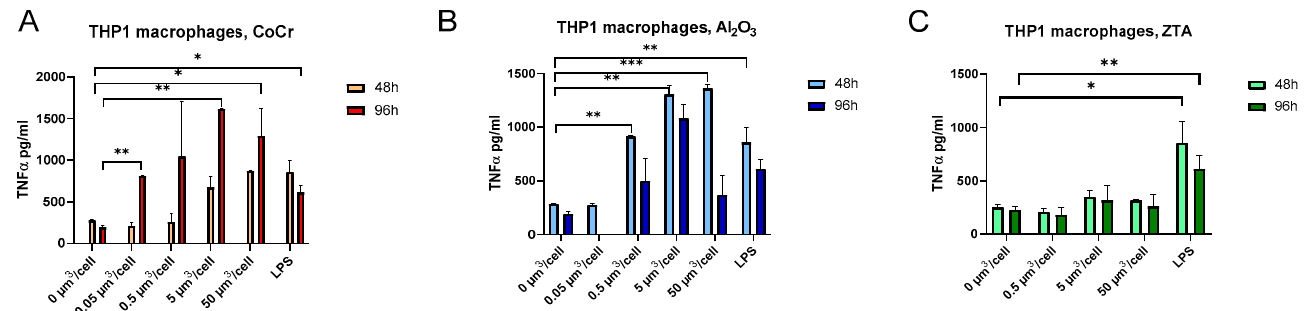
Figure 2. TNF- α secretion by THP-1 macrophages is activated by CoCr and Al 2 O 3 particles but not by ZTA particles. THP-1 macrophages were treated with the test particles for 48 h or 96 h, and the concentration of secreted TNF- α was measured in the cell supernatants by ELISA. Treatment with CoCr particles ( A ). Treatment with ZTA particles ( B ). Treatment with Al 2 O 3 particles ( C ). LPS was used as a positive control. The results are expressed as the mean ± SEM. *— p < 0.05; ** p ≤ 0.01; *** p ≤ 0.001.